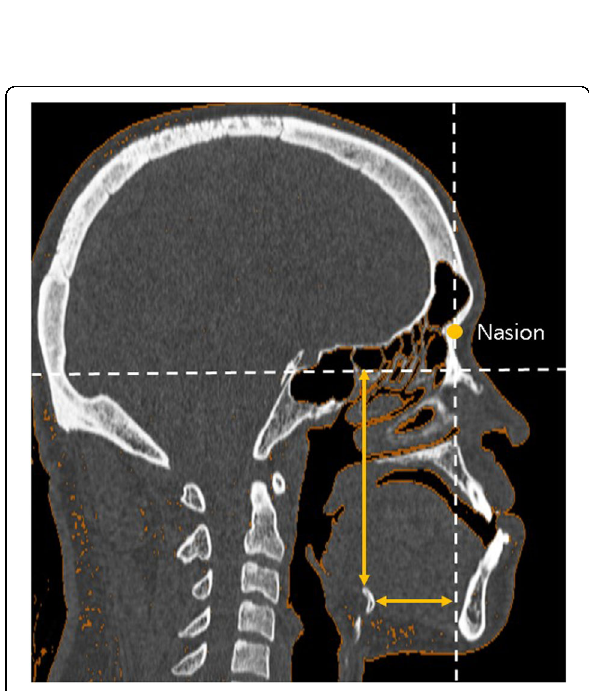
Fig.2 Vertical and horizontal positioning of the hyoid bone was measured in CT (mm). The x -axis was defined as the line tangent to the inferior point of the sella turcica and parallel to the FH plane, while the y -axis was defined as the line passing through the nasion and perpendicular to the x -axis